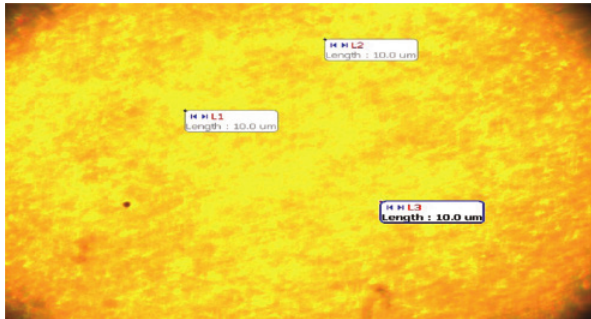
Figure 2: Particle size distribution of silver